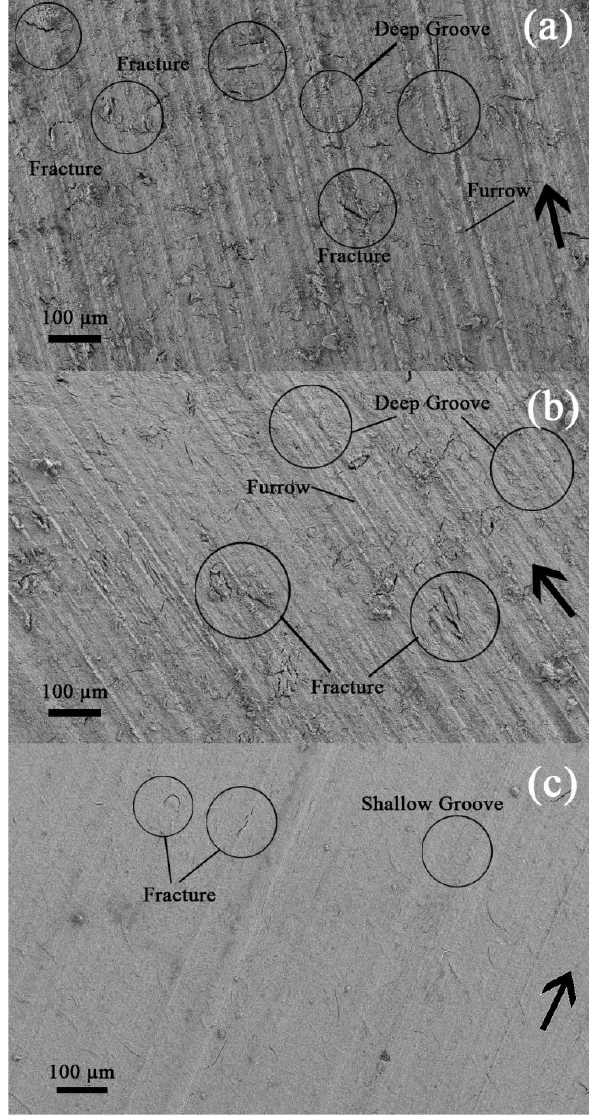
Figure 7. SEM micrographs of the worn surfaces for HYB composite and PHY composite under a sliding speed of 1.022 m/s and 30 N applied load. ( a ) Pure phenolic, ( b ) 5 wt% PHY composite, ( c ) 5 wt% HYB composite. → sliding direction.